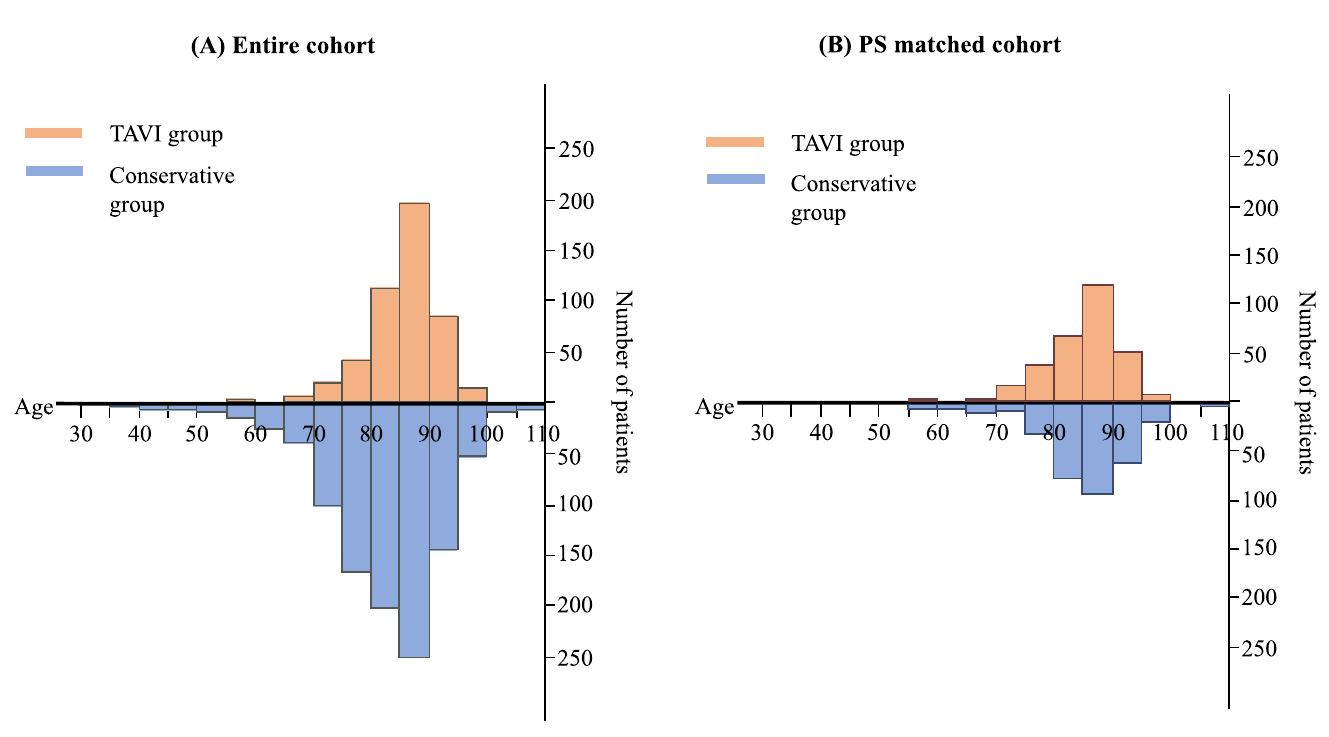
Fig 2. Distribution of age. (A) Entire cohort. (B) PS matched cohort (B) PS, propensity score; TAVI, transcatheter aortic valve implantation.